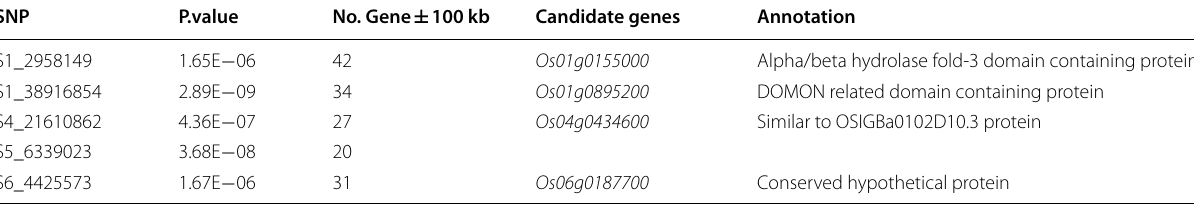
Markers were named based on their genomic position on the reference sequence (cv Nipponbarre, IRGSP v1) for S[chromosome]_[bp position on the chromosome]. When the trait-associated SNP fell into an annotated gene, the gene name was indicated in the column of “Candidate gene”. Annotation was from RAP-DB